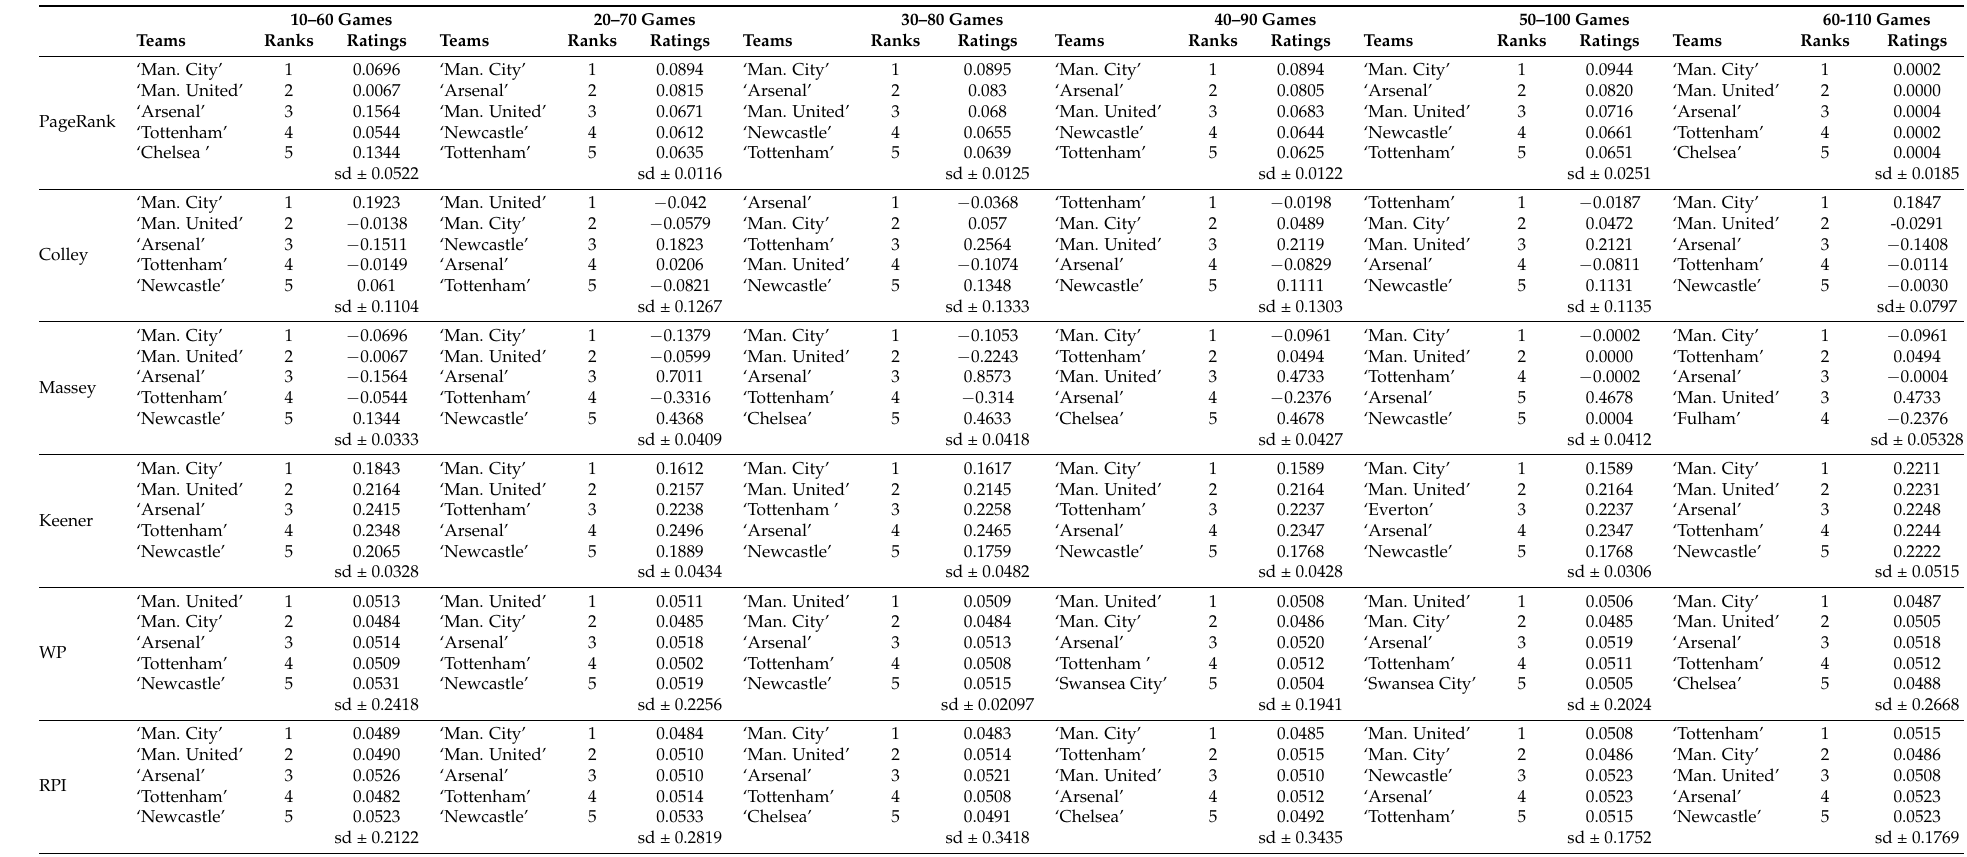
Table A1. Detailed comparison of top-5 teams rate–rank by rolling window